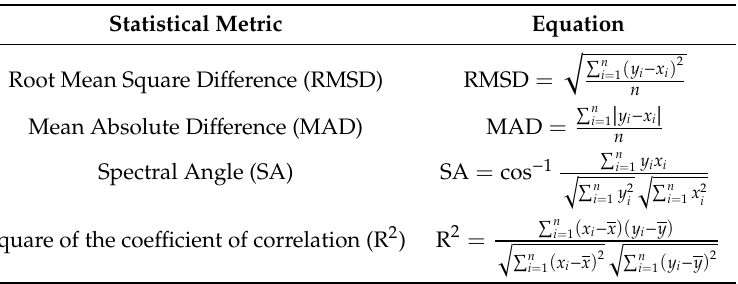
Table 3. Statistical metrics used to assess the agreement of TOA radiances among the datasets; n is the number of concurrent observations of the match-up, x is for PRISMA, y is for in situ simulated or